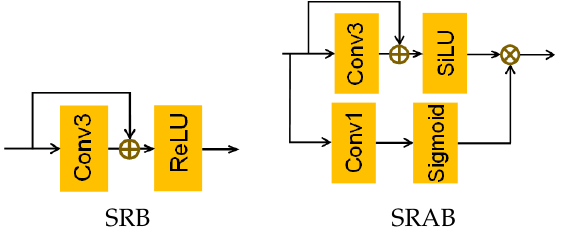
Figure 3. The comparison between SRB and SRAB. ( Left ), the structure of SRB. ( Right ), the structure of the SRAB; and represent the element-wise summation and the element-wise summation ⊕ ⊗ Figure 3. the comparison between SRB and SRAB. Left, the structure of SRB. Right, the structure of multiplication, SRAB, and © represent the element-wise summation and feature fusion, respectively. ⊕